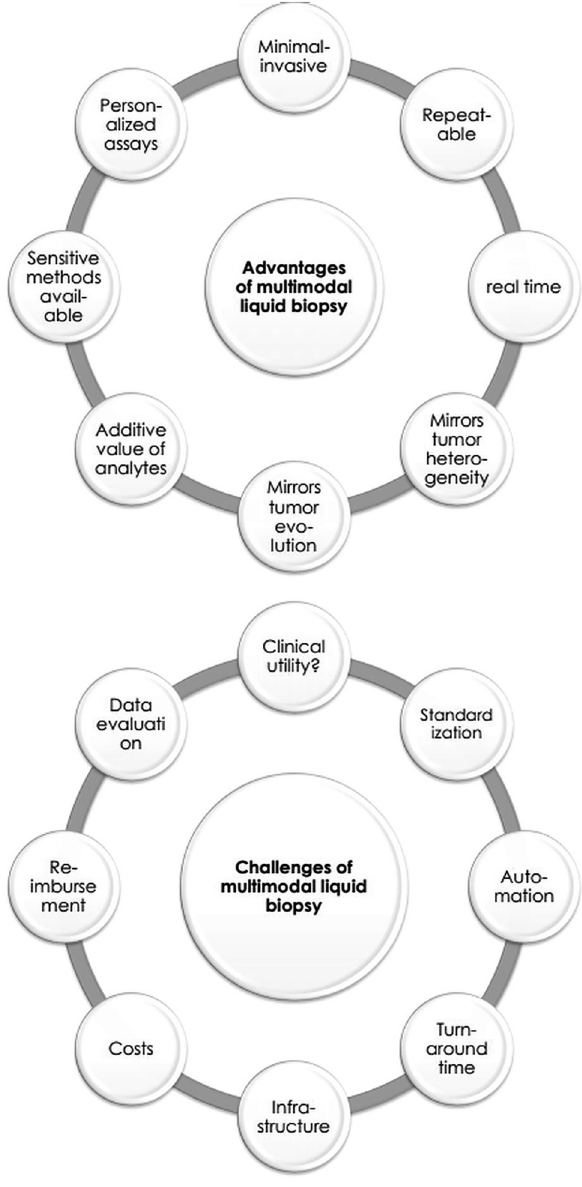
Figure 3: Advantages and challenges of multi-modal liquid biopsy